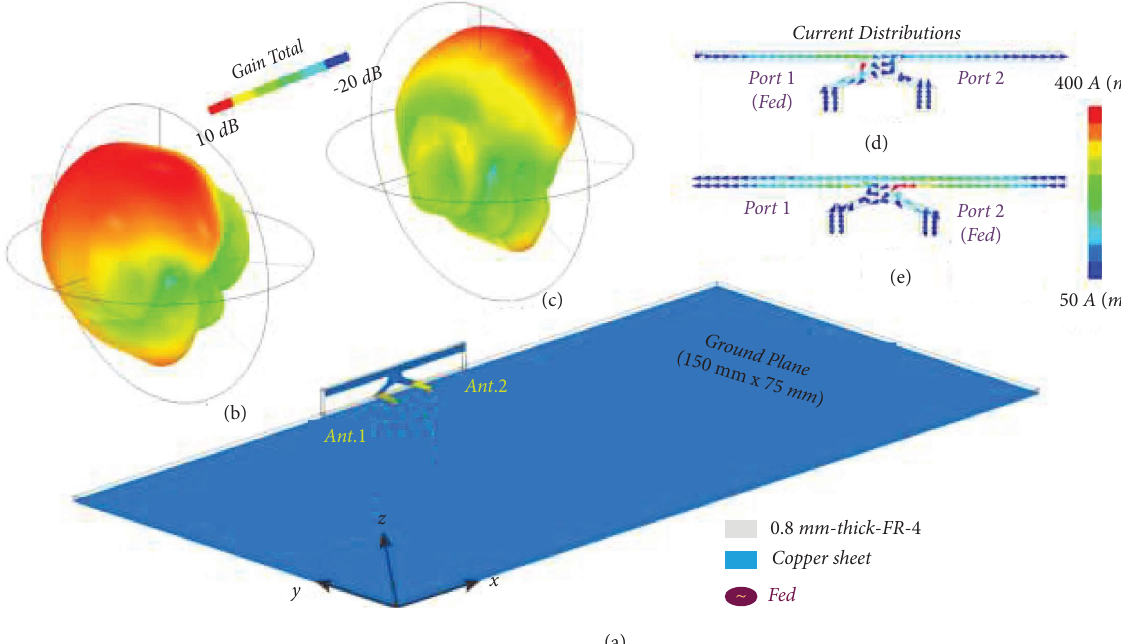
Figure 5: (a) Overall view of the dual-port microstrip antenna pair. Te far-feld radiation pattern of the dual-port microstrip antenna pair at 3.5GHz. (b) When port 1 is excited. (c) When port 2 is excited. Surface current distributions are at 3.5GHz. (d) When port 1 is excited. (e) When port 2 is